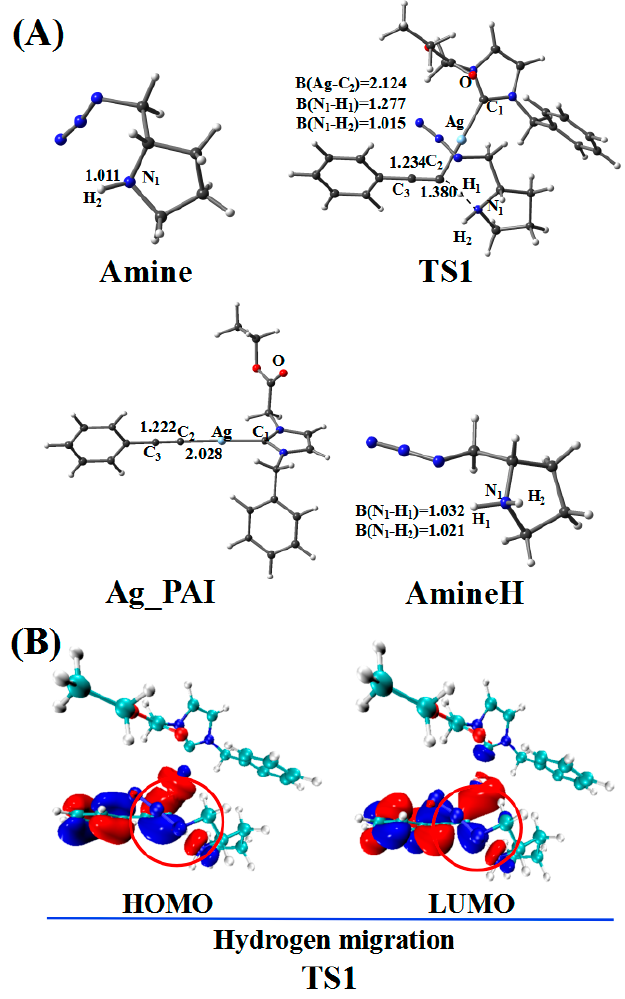
Figure 4. ( A ) Optimized geometries in the hydrogen migration pathway involving amines; the critical bond lengths are in Å. ( B ) Frontier orbitals of TS1.